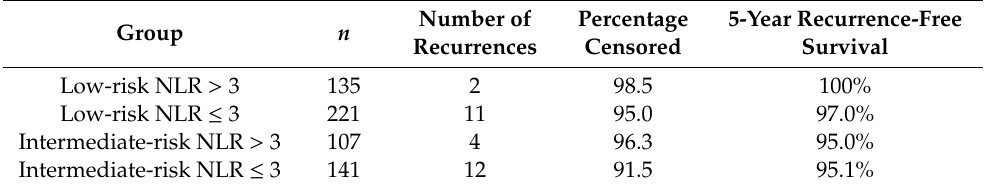
Table 3. CAPRA risk group combined with the neutrophil / lymphocyte ratio (NLR) to predict for BCR (Kaplan–Meier comparison of all groups p =